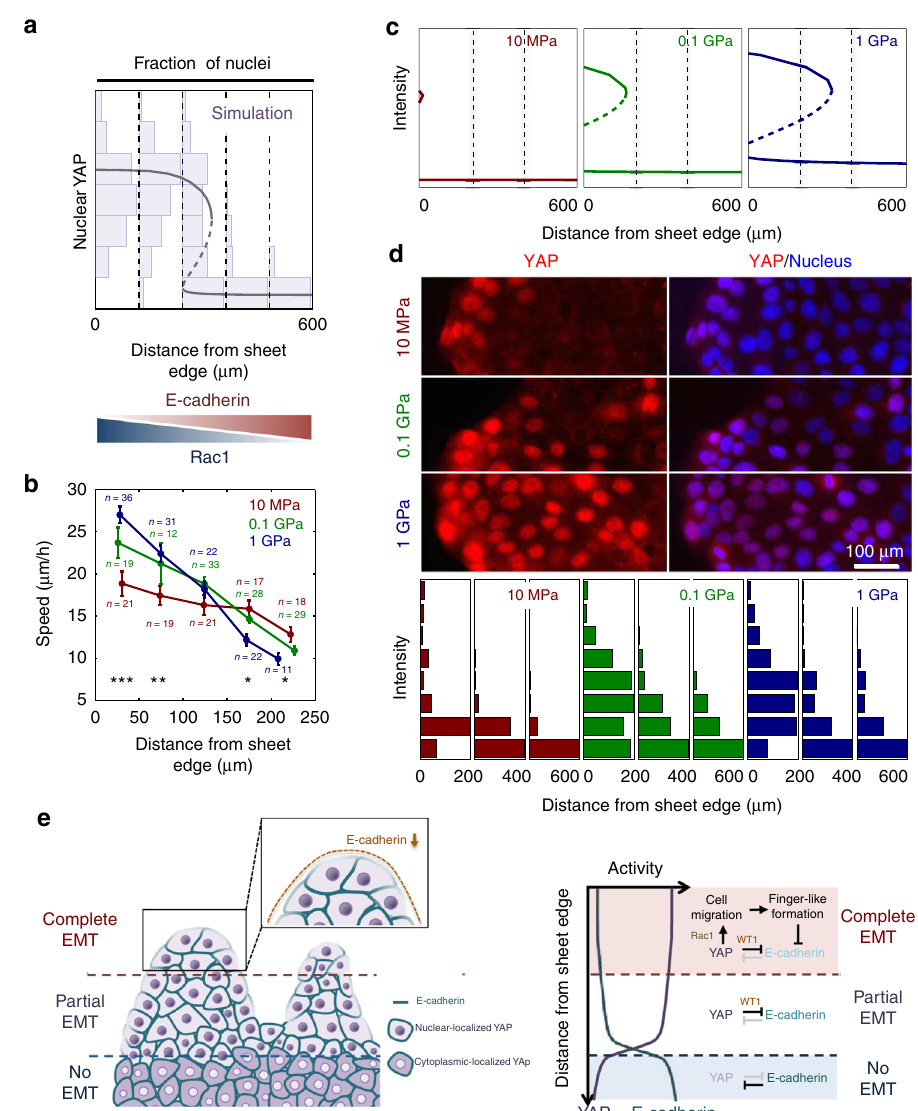
Fig. 7 Double-feedback loop with YAP activated on NRA regulating EMT. a Simulation result showing that feedback mechanisms lead to emergence of two stable states of high and low YAP activity, indicating epithelial (low Rac1, high E-cadherin, and low YAP) and partial EMT (high Rac1, low E-cadherin, and high YAP) states depending on Rac1 and E-cadherin activity in this system. b Cell migration speed on NRAs with different rigidity values, suggesting that rigidity can regulate the basal rate of YAP activation at different initial distances from the edge of the sheet (all error bars are S.E.M, each number of independently analyzed cells, n , is indicated, * = statistical signi fi cance of the speed of cells on NRA in which the rigidities are 10 MPa vs. 1 GPa, * P < 5 × 10 − 2 , ** P < 1 × 10 − 2 , and *** P < 5 × 10 − 3 , all two-sided Student ’ s t -test). c Simulated bimodal distribution of YAP activity as a function of the distance from the sheet edge on NRA substrata of different rigidity values. d Rigidity-dependent YAP localization in nuclei of cells cultured on NRA. Immuno fl uorescence staining of YAP showing nuclear localization at different distances from the sheet edge on NRAs with different rigidity values (top). Fractions of nuclei displaying different intensities of YAP staining as a function of the distance from the sheet edge on NRA having different rigidity (bottom) (see details in Supplementary discussion and Supplementary Fig. 17). The samples were fi xed after 6 h to remove stencils and induce epithelial expansion. e Schematic description of the regulation of EMT by YAP-mediated topographically induced mechanical input, showing full EMT in marginal cells exposed to cell-free areas at the fronts of FLPs, partial EMT in extensive marginal areas, and epithelial organization (no EMT) in the areas most distant from the